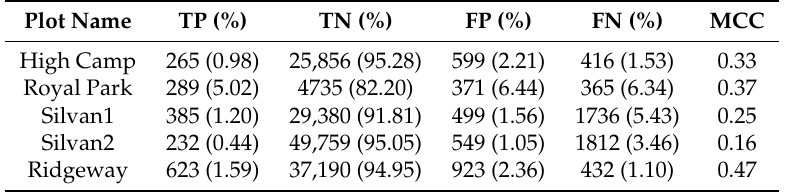
Table 3. Summary of confusion matrix results between TLS Non-normalised point cloud and validation frame data. For each plot, True Positives (TP), True Negatives (TN), False Positives (FP), False Negatives (FN) and Matthews Correlation Coefficient (MCC) are